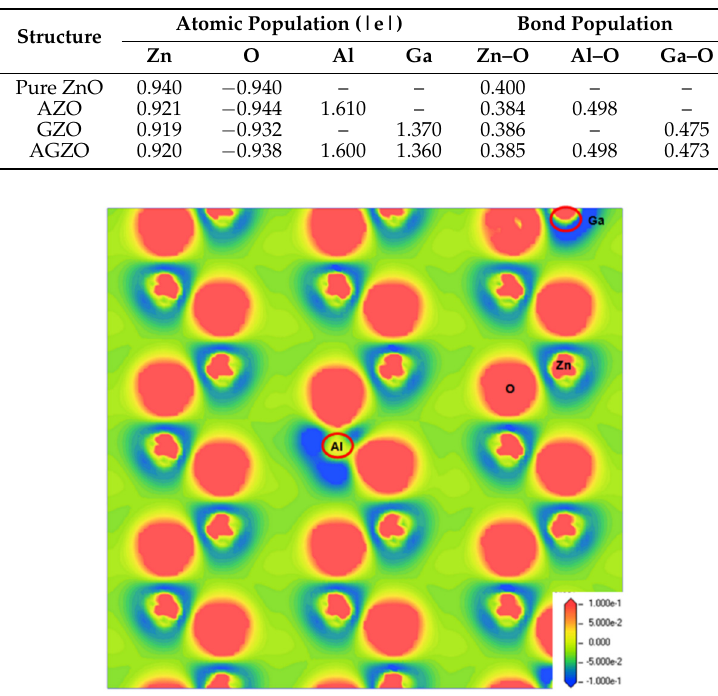
Table 2. Mulliken atomic and bond populations of Al/Ga-doped ZnO.